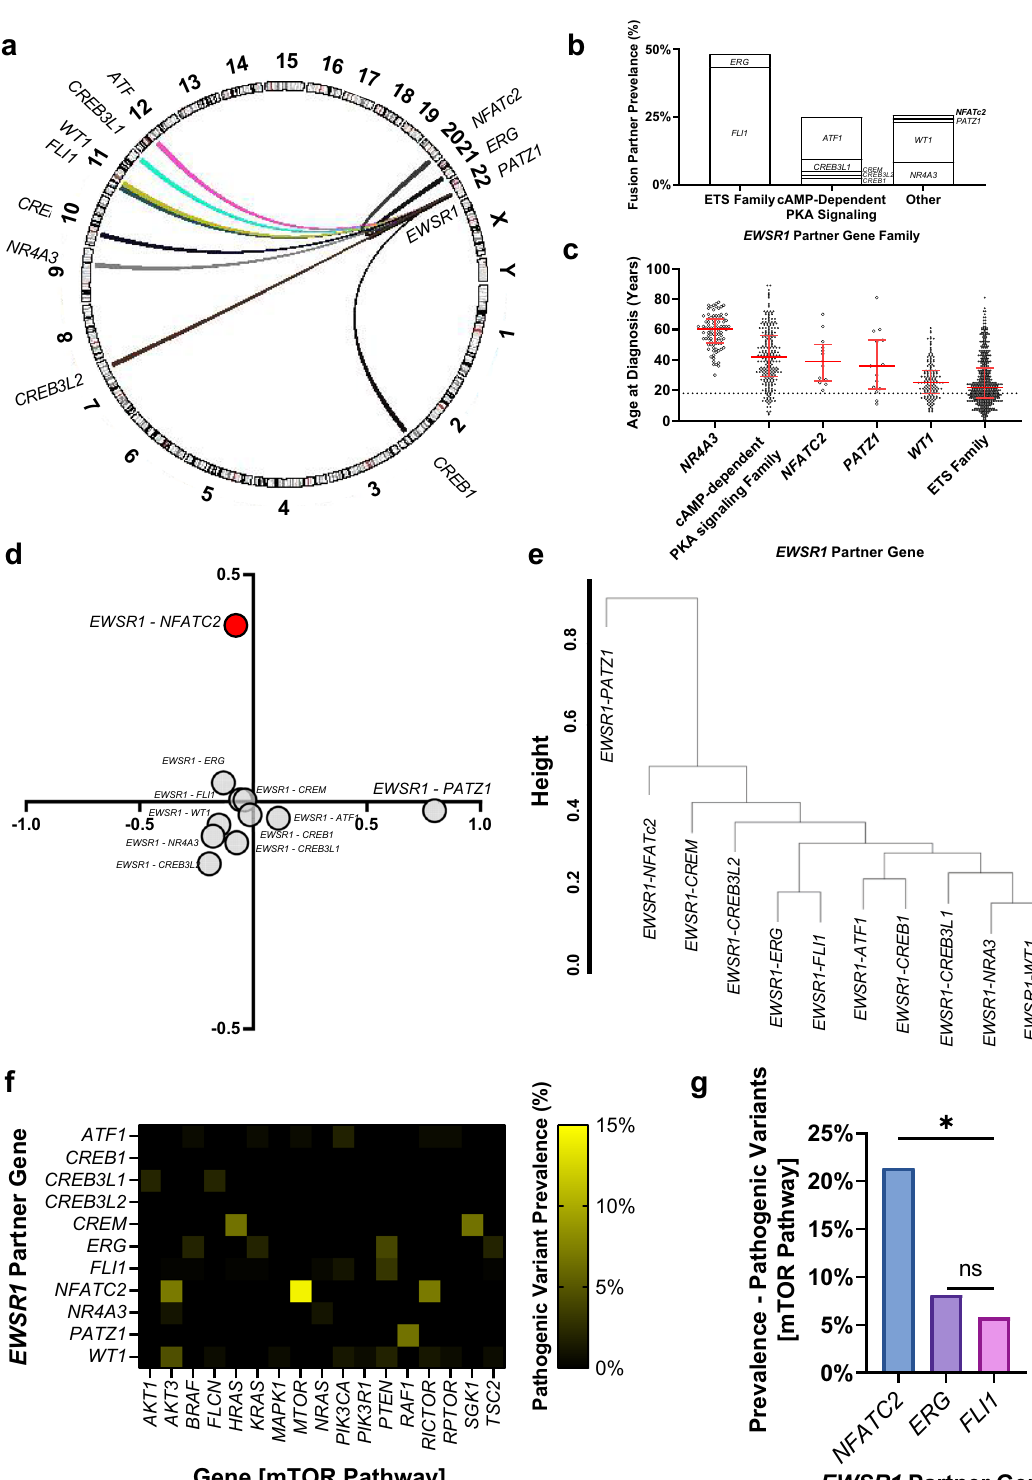
followed by ifosfamide and etoposide (VDC/IE). Adjuvant therapy provided stabilization of disease with some reduction of